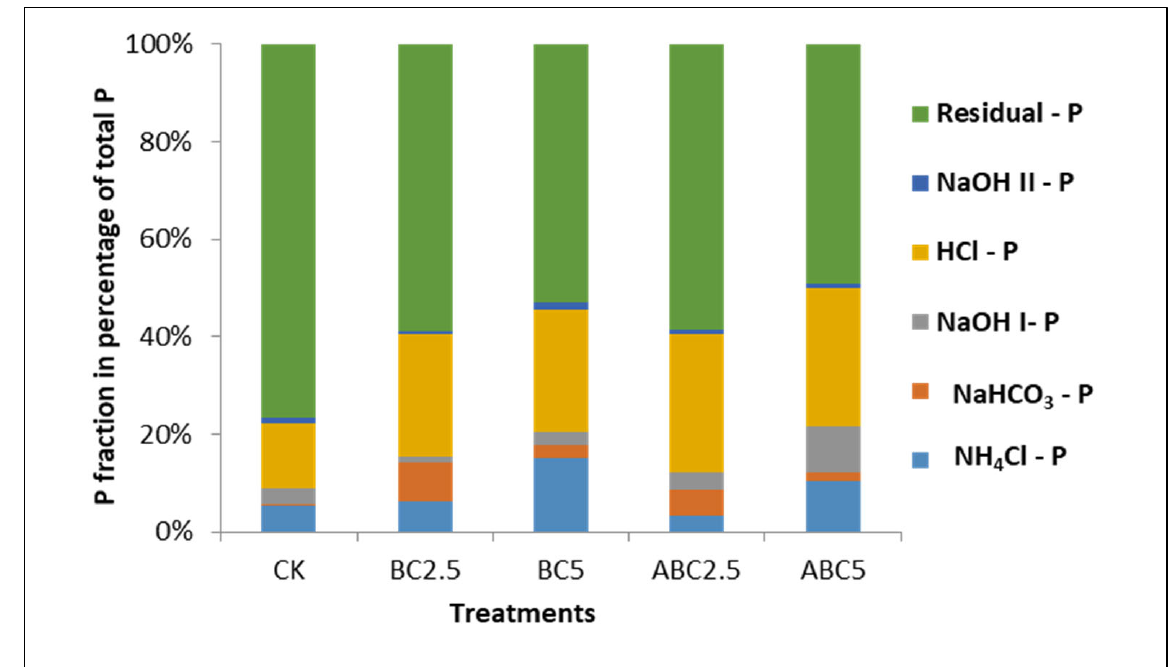
Figure 14. Effect of BC and ABC applied at different rates on P fractionation on soil treated with 0 ppm P. CK = Control, BC2.5 = Biochar added at 2.5% w / w , BC5 = Biochar added at 5% w / w , ABC2.5 = Acidified biochar added at 2.5% w / w , and ABC5 = Acidified biochar added at 5% w / w .